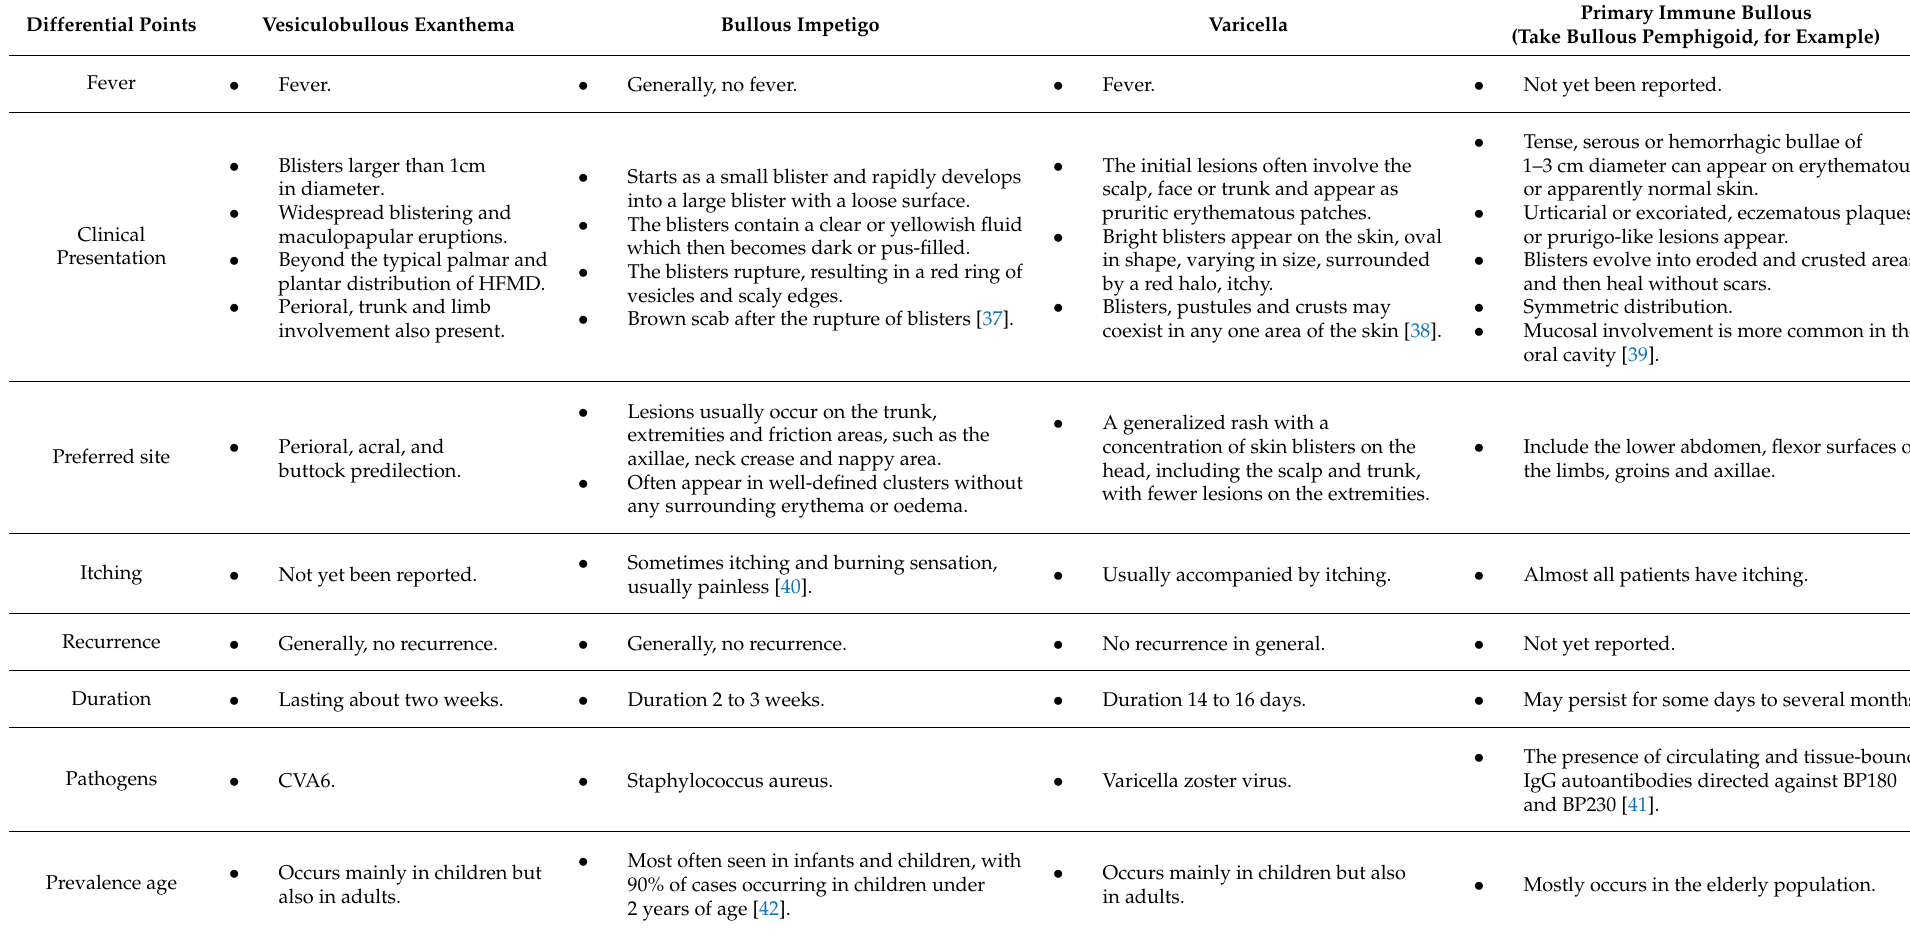
Table 4. Differential diagnosis of vesiculobullous